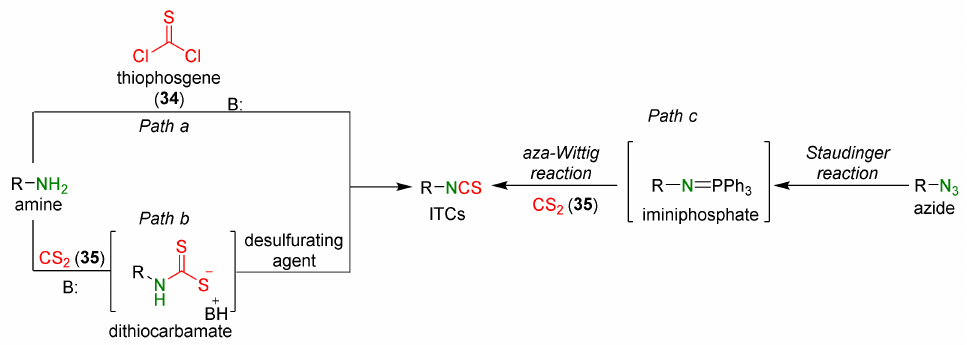
Figure 8. Synthesis of ITCs using amines ( Path a and b ) or azides ( Path c ) as